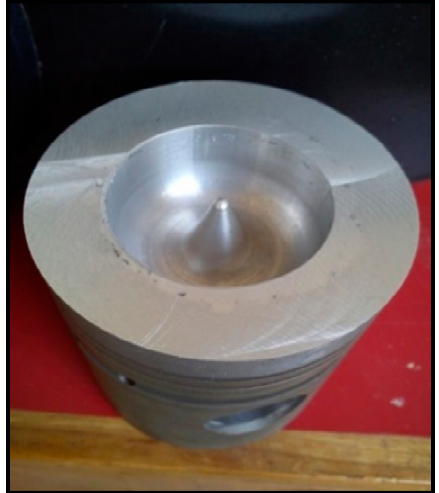
Figure 2. Toroidal re-entrant combustion chamber. Table 3. Descriptions of the test rig.